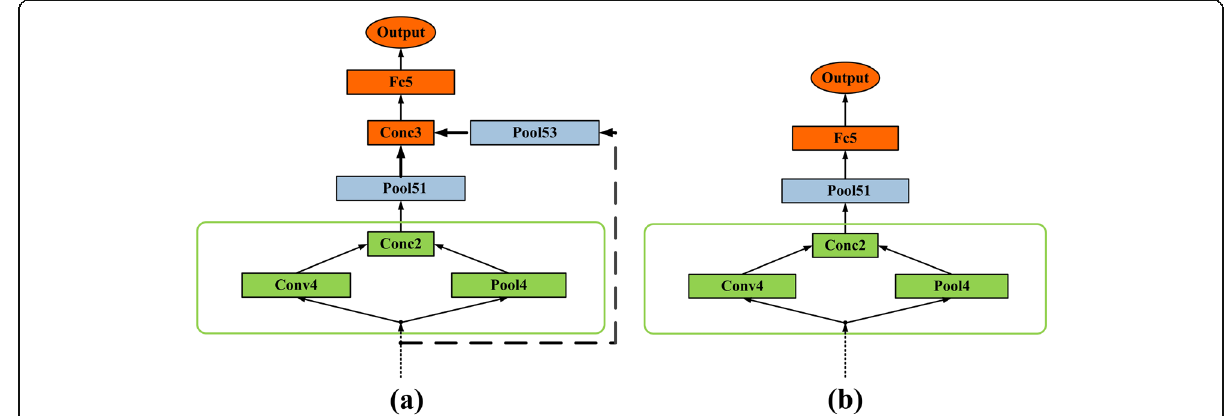
Fig. 3 Architecture of a BN1 and b BN2